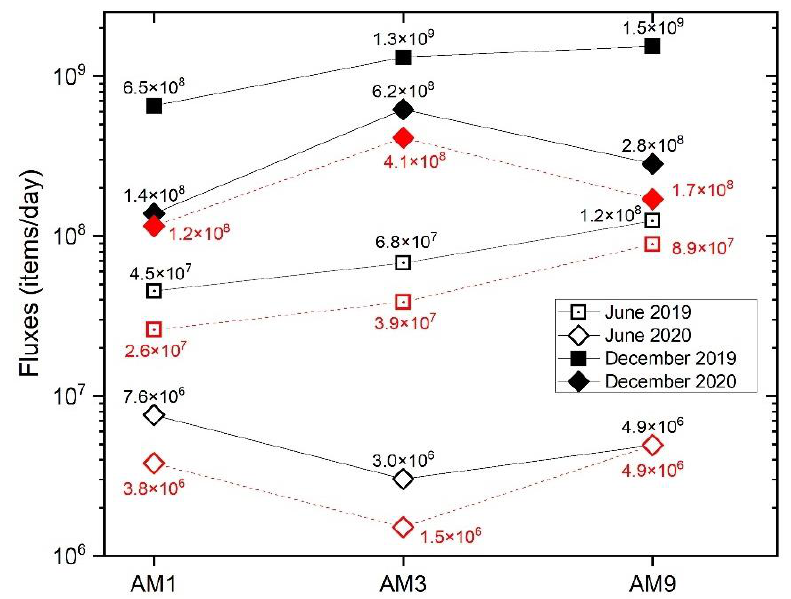
Figure 10. Fluxes (items/day) of total (MP*, black marker) and natural (red marker) particles at each sampling site along MC in the investigated seasons.